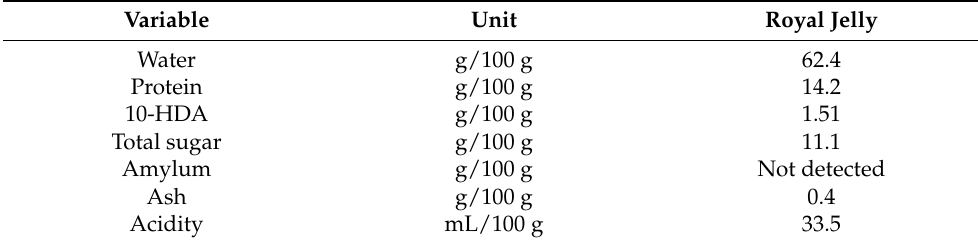
Table 1. Physicochemical parameters of royal